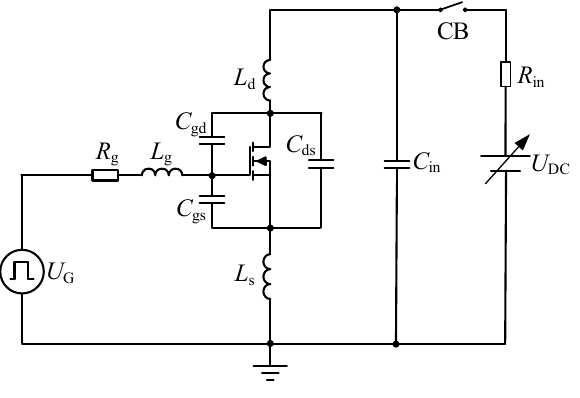
Figure 4. Schematic of the test circuit.